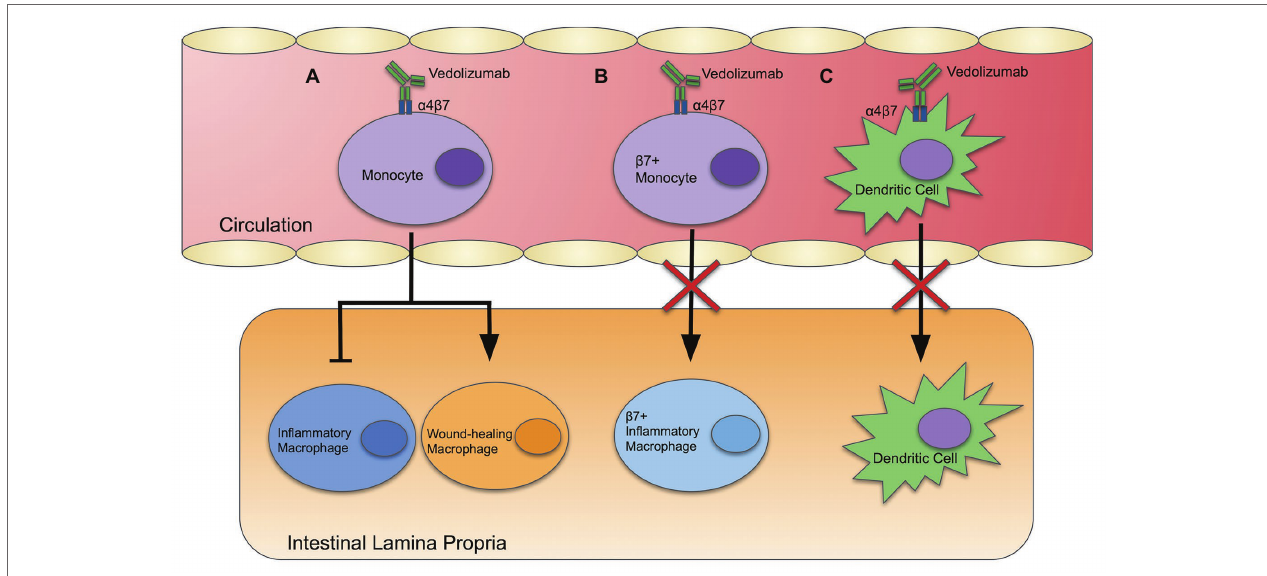
FIGURE 1 | Vedolizumab: three potential mechanisms of action. (A) Vedolizumab binds α 4 β 7 integrin, which alters gene expression of blood monocytes, skewing the population toward a wound-healing phenotype, and away from an inflammatory phenotype. (B) Vedolizumab binds to α 4 β 7 integrin on blood monocytes, thereby inhibiting their ability to enter the intestinal epithelium. (C) Vedolizumab blocks localization of cDC and pDCs in the intestinal epithelium by binding α 4 β